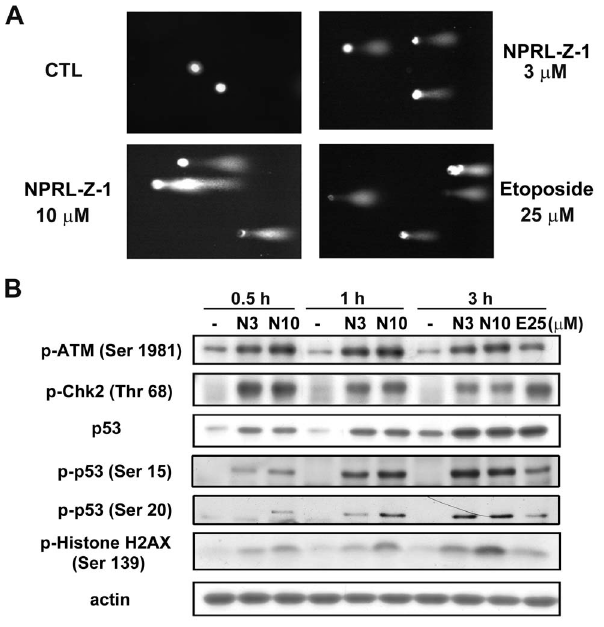
Figure 4. Effects of NPRL-Z-1 on DNA DSBs and DNA checkpoint pathway. (A) A498 cells were seeded and treated with NPRL-Z-1 or etoposide for 30 min and processed for the comet assay as detailed in Materials and Methods. (B) A498 cells were incubated with DMSO or 3 or 10 m M NPRL-Z-1 for the indicated time periods. After treatment, cells were harvested and lysed for detection of the expression of indicated protein via western blotting. N3, N10 and E25 indicated as NPRL-Z-1 3 m M, 10 m M and etoposide 25 m M, respectively.